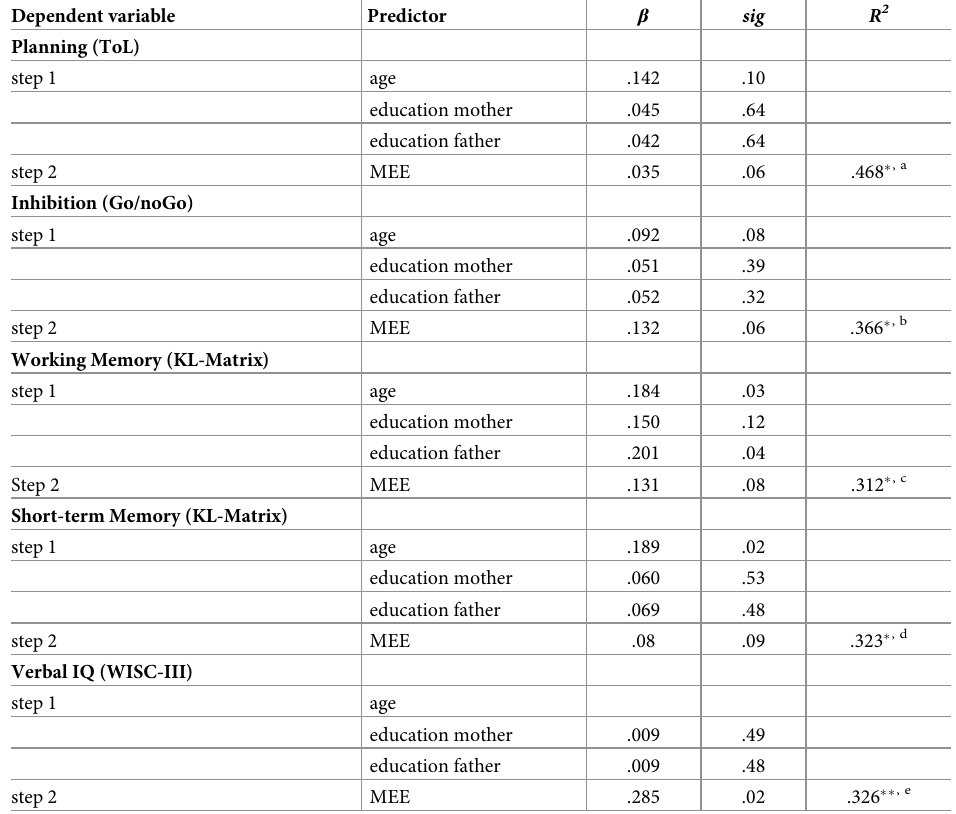
Table 3. Predictions of executive functions: Results of linear regression